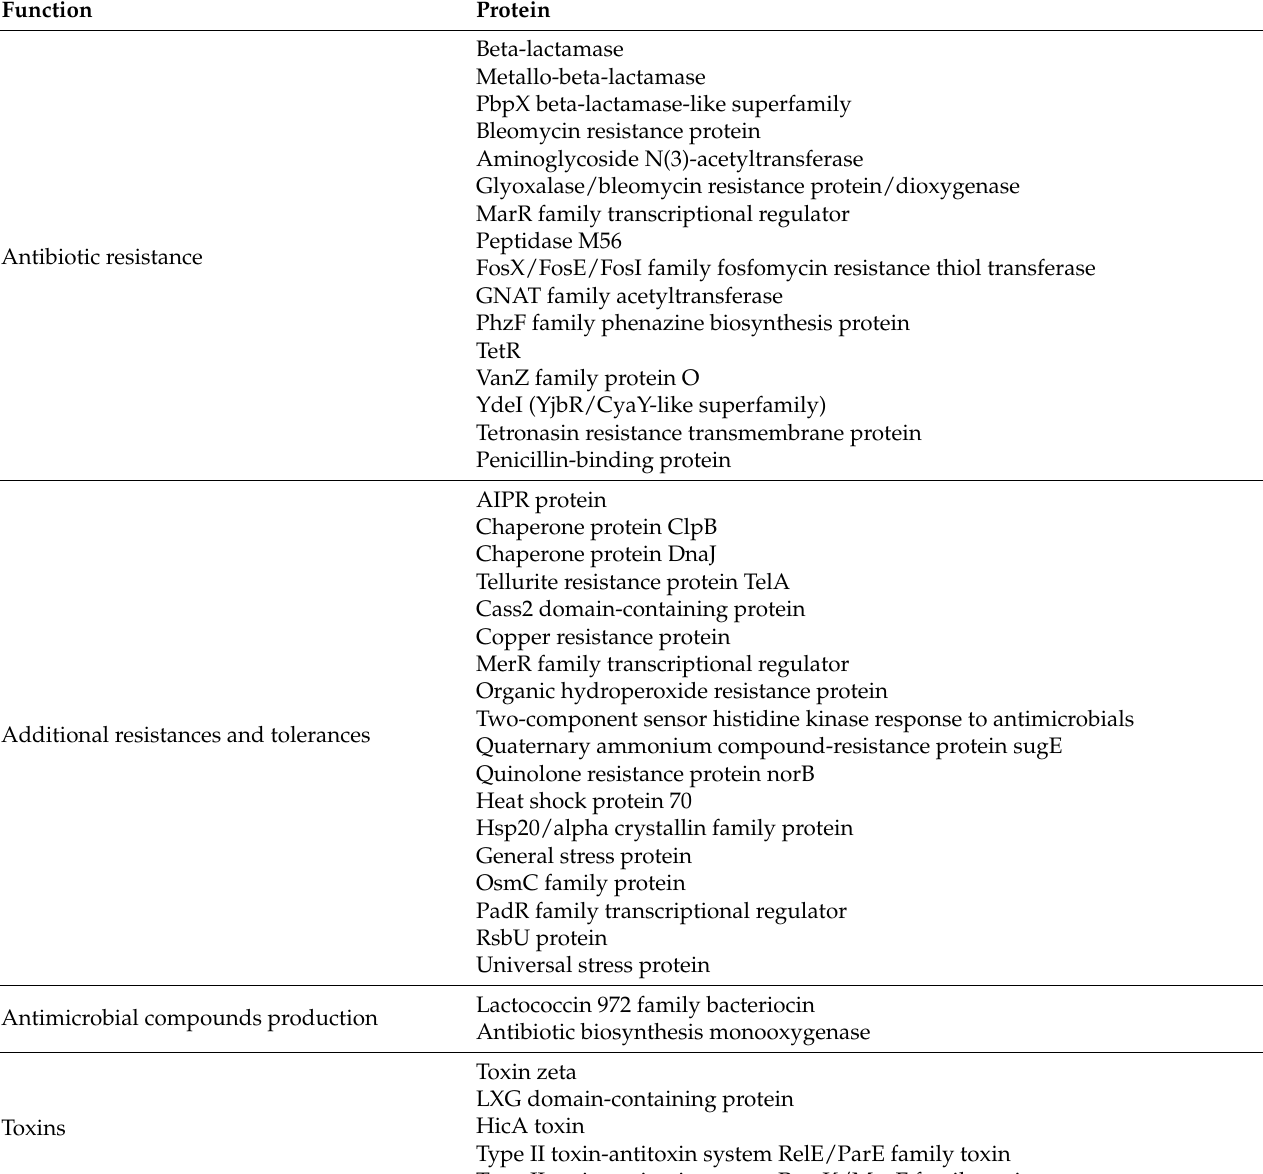
Table 2. Proteins corresponding to bacterial resistance to antibiotics, antimicrobial related proteins and other virulence factors, identified in the Listeria strains